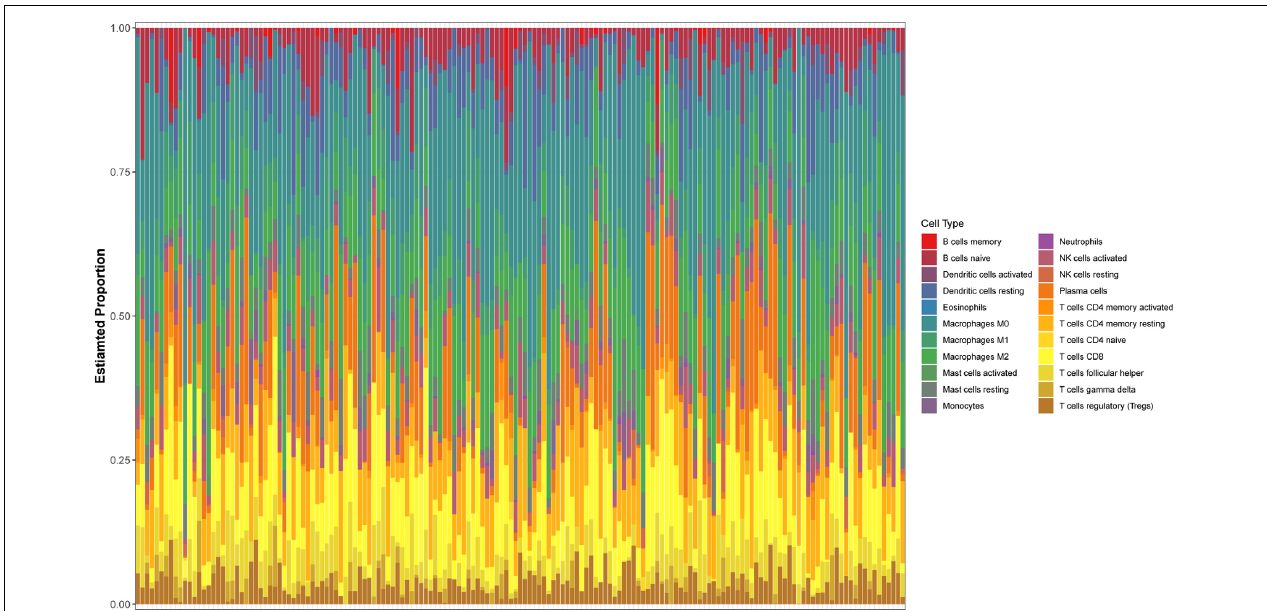
FIGURE 1 | Evaluation of 22 tumor-infiltrating immune cell